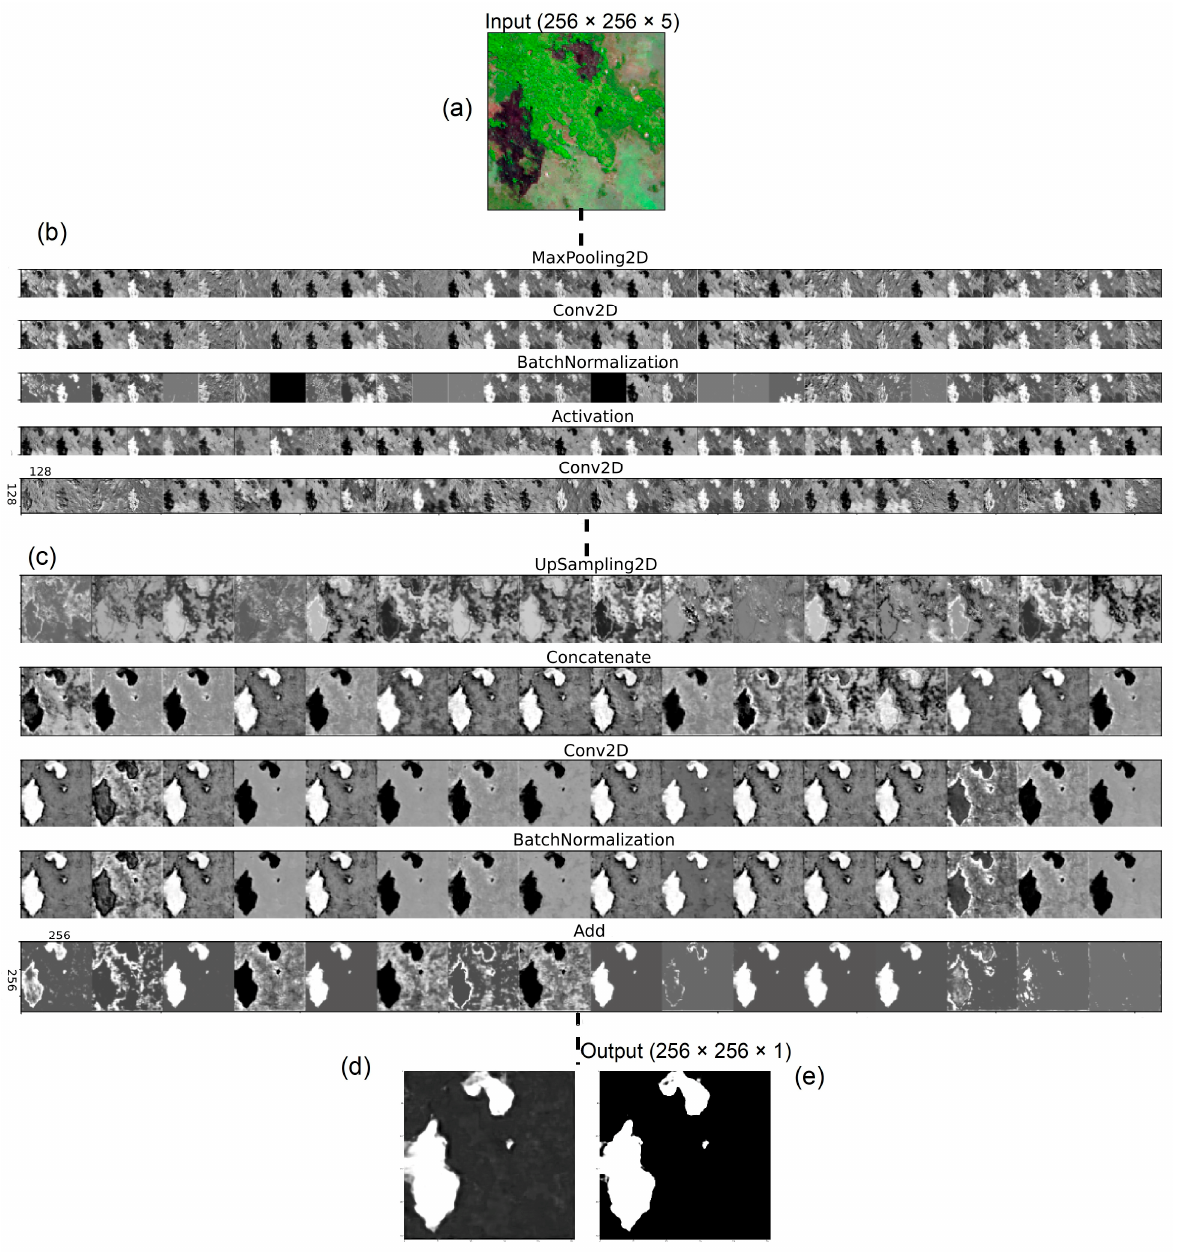
Figure 4. The feature maps that are produced in ( b ) a block of the contraction path and ( c ) a block of the expansion path by fitting the trained RAUNet on ( a ) an input image patch (256 × 256 × 5) including the top derivatives of Sentinel-2. ( d , e ) The outputs of the model.